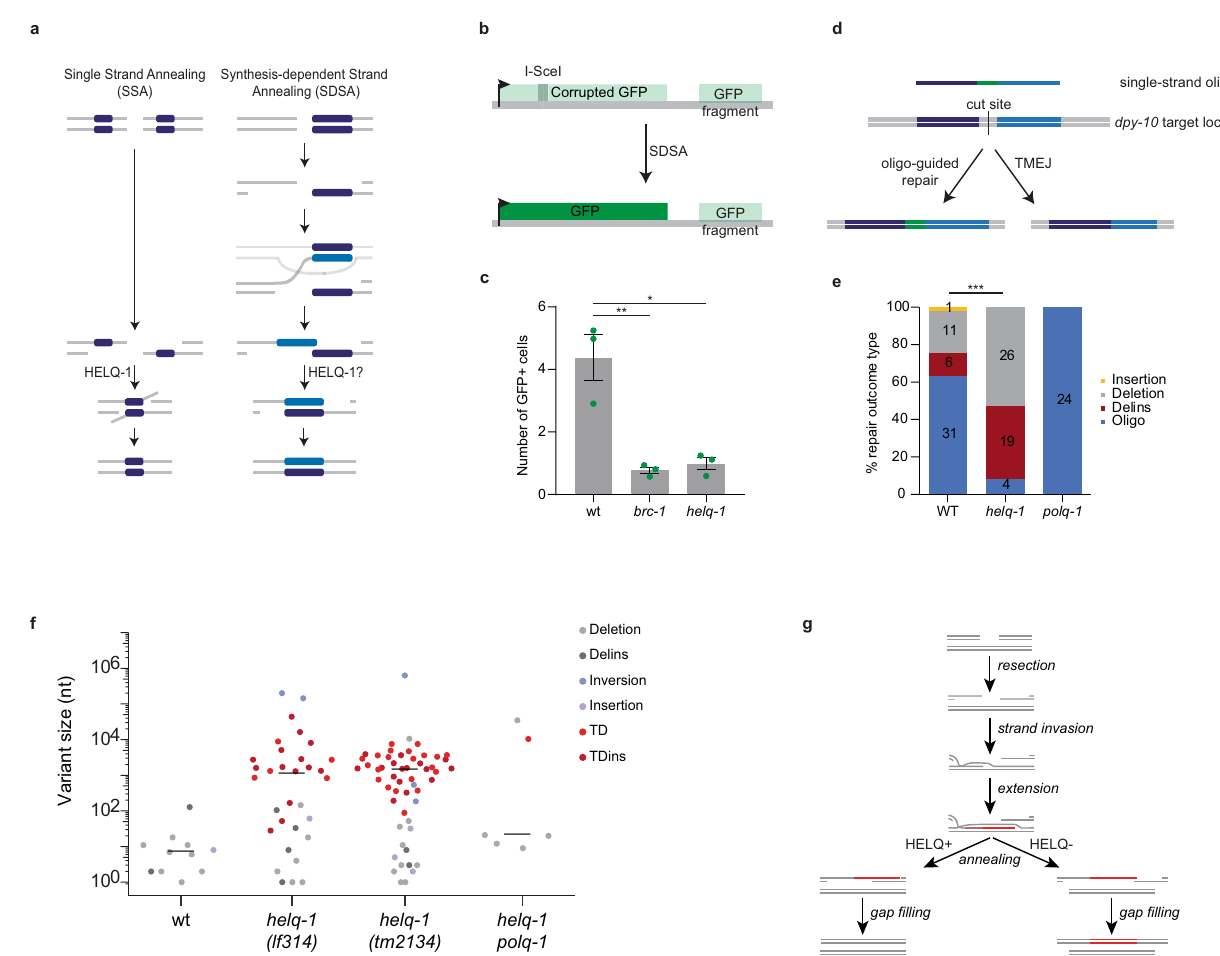
Fig. 4 HELQ-1 acts in synthesis-dependent strand annealing and suppresses tandem duplications. a Models for SSA and SDSA repair of DSBs. Homologous stretches of DNA are depicted in dark blue. b Schematic representation of the SDSA reporter 39 . A DSB can be introduced by the I-SceI endonuclease at its recognition site positioned within a corrupted GFP expression cassette. SDSA repair using a GFP segment cloned downstream of the expression cassette will restore the GFP ORF leading to GFP expressing animals. c Histograms depicting the average number of GFP expressing cells per worm for the indicated genotype. Experiments are performed in triplicate (* P < 0.05, ** P < 0.01; two-sided t -tests). P value WT vs. brc-1 : 0.0085. P value WT vs. helq-1 : 0.0115. Each dot represents the average number of each replicate. Error bars represent SEM. Quanti fi cations are provided as a Source Data fi le. d Schematic representation of the CRISPR/Cas9-induced gene correction assay. CRISPR-induced DSB at the dpy-10 locus can be repaired via end- joining or using an injected single-stranded oligo as a template. The sequence of the oligo differs from the target locus at the centre (in green). Mutation sequences are provided as a Source Data fi le. e Histogram depicting the different categories of repair outcomes. Insertions are depicted in yellow, simple deletions in grey, deletions containing insertion in red, outcomes of repair using the oligo are depicted in blue. The difference in ratio between ssODN- guided repair and indels were tested using Chi-square test (***P < 0.001). f Size distribution of structural variations that accumulate in the genomes of the indicated genotype (wild-type data derived from ref. 46 ). Mutation sequences are provided as a Source Data fi le. g Mechanistic model for the aetiology of tandem duplications (TDs) in helq-1 mutant genetic